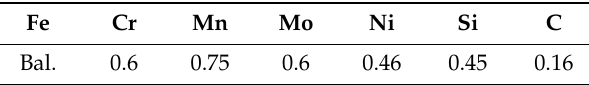
Table 1. Steel compositions